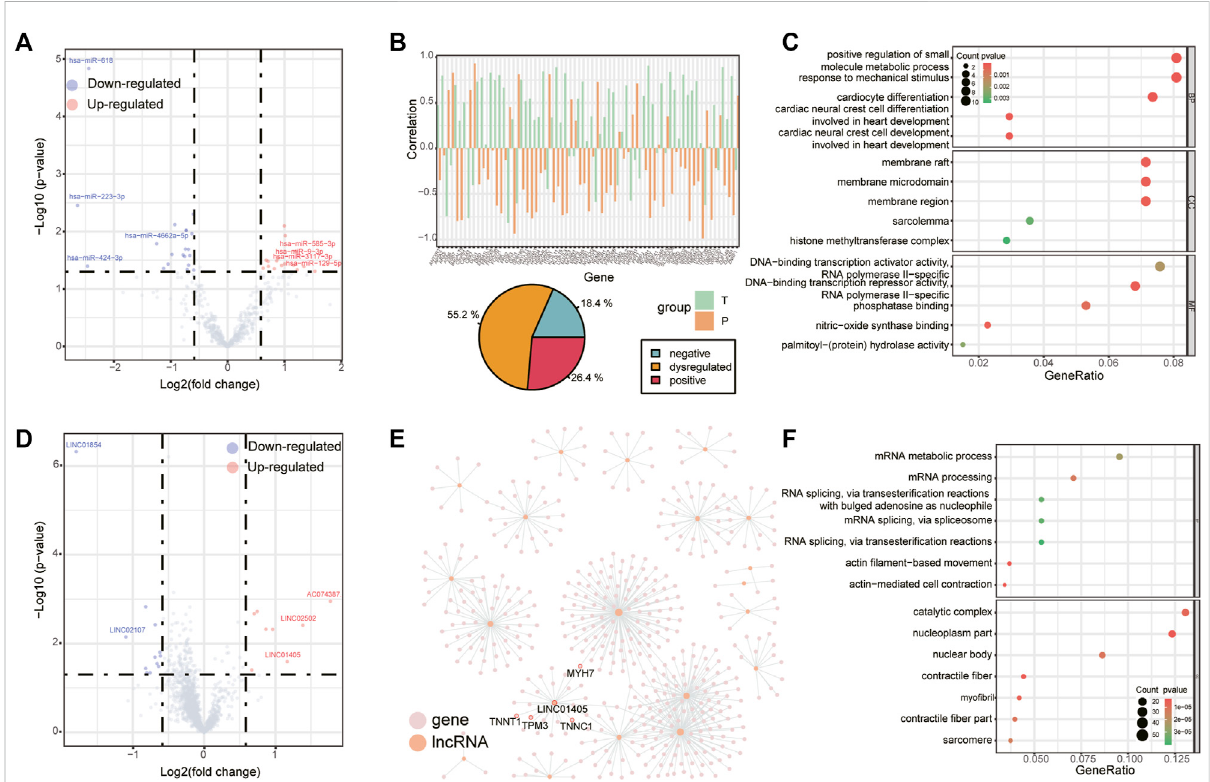
FIGURE 2 Differentially expressed miRNAs and lncRNAs. (A) Volcano plot of differentially expressed miRNAs in RCT. Red points denote up-regulated miRNAs, and blue points denote down-regulated miRNAs. The most up- or down-regulated miRNAs are labeled. (B) Changes in the correlation between hsa-miR-9-3p and its target genes, bar chart (top panel) shows the correlation of those miRNA-mRNA pairs which were positively (negatively) correlated to hsa-miR-9-3p in supraspinatus muscles but negatively (positively) correlated to hsa-miR-9-3p in unharmed subscapularis muscles (we de fi ne this correlation pattern as “ dysregulated ” ), pie chart (bottom panel) shows the proportion of miRNA-mRNA pairs with both negative correlation, both positive correlation or “ dysregulated ” in supraspinatus muscles and unharmed subscapularis muscles. (C) GO enrichment analysis for all target mRNAs of hsa-miR-9-3p. (D) Volcano plot of differentially expressed lncRNAs. (E) Co-expression network of differentially expressed lncRNAs. Pink points denote mRNAs and orange points denote lncRNAs. (F) GO enrichment analysis for all co-expressed mRNAs of differentially expressed